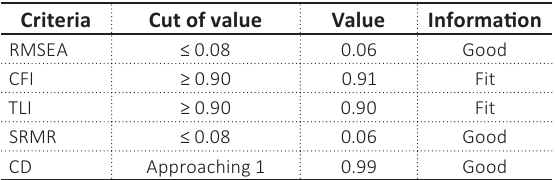
Figure 2. Structural equation modeling result Table 2. Goodness of fit